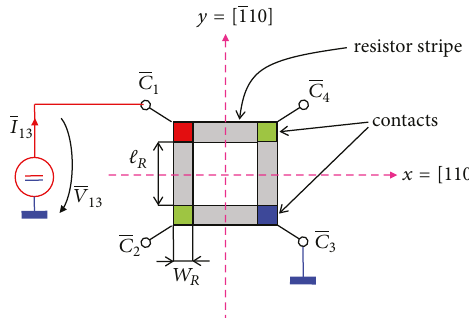
Figure 17: Wheatstone bridge with two perpendicular mirror- symmetry axes 𝑥 and 𝑦 comprises four resistor stripes. It can be used for the measurement of 𝜎 𝑥𝑥 − 𝜎 𝑦𝑦 on a chip made of (100)- silicon. The device is supplied with electrical power at the contacts 𝐶 𝐶 1 – 3 . The output signal is tapped between similarity of the Wheatstone bridge with the inverted Greek cross of Figure 16 when the inner square of the bridge arrangement is filled with resistive material.